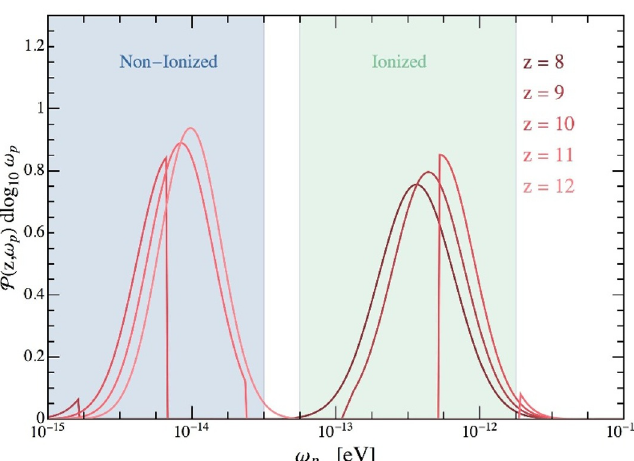
Figure 7 . Probability distribution function characterizing distribution of plasma frequencies in the IGM during reionization, assuming the ‘strongly inhomogeneous’ scenario (in which reionization is assumed to progress from over-densities to under-densities). The left region captures the evolution of the predominantly neutral medium x e (cid:24) 10 (cid:0) 4 , while the right region shows the evolution of the predominantly ionized regions x e (cid:24) 1 : 08. The mean free electron fraction is assumed to be a tanh function centered at z = 10 with width (cid:1) z = 0 :